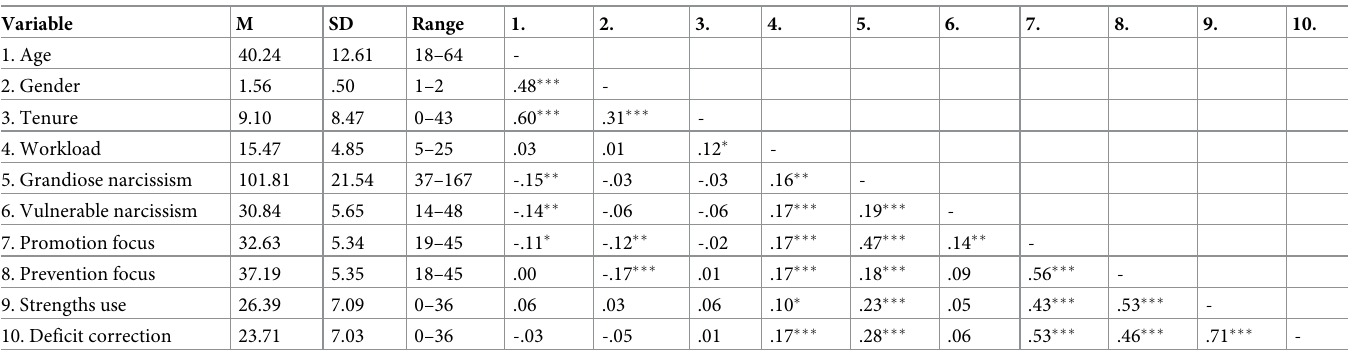
Table 1. Descriptive statistics and bivariate correlations among the study